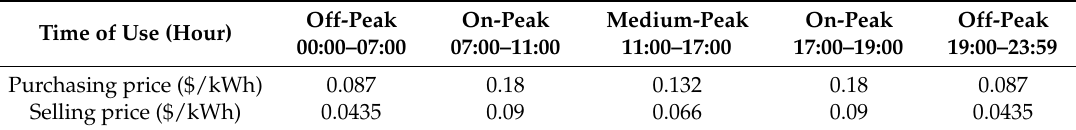
Table 3. Ontario Electricity Tariff Periods.